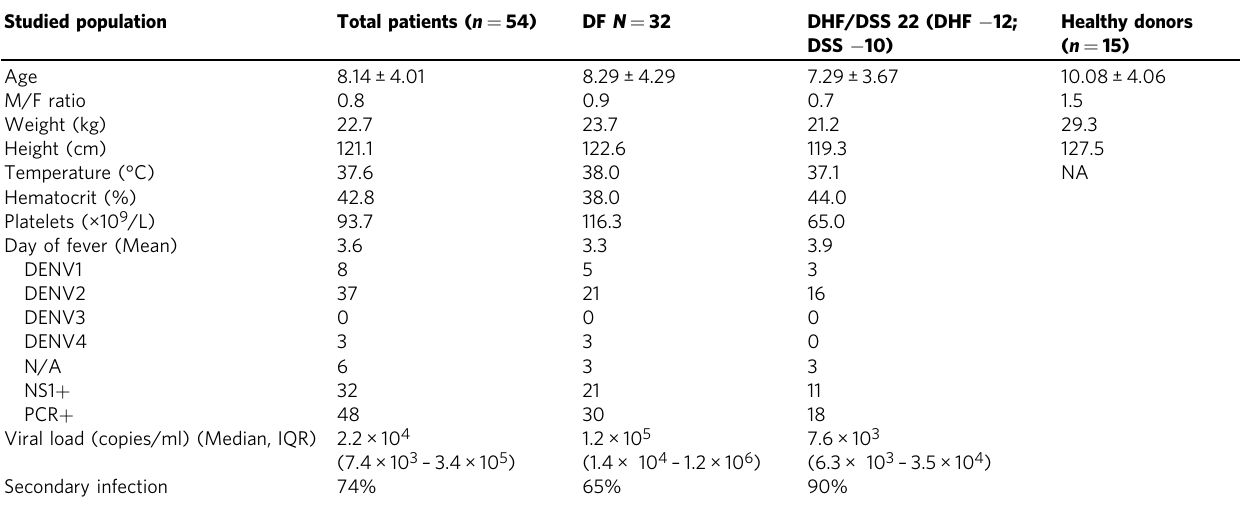
Table 1 Demographic data and clinical parameters of the studied population. Studied